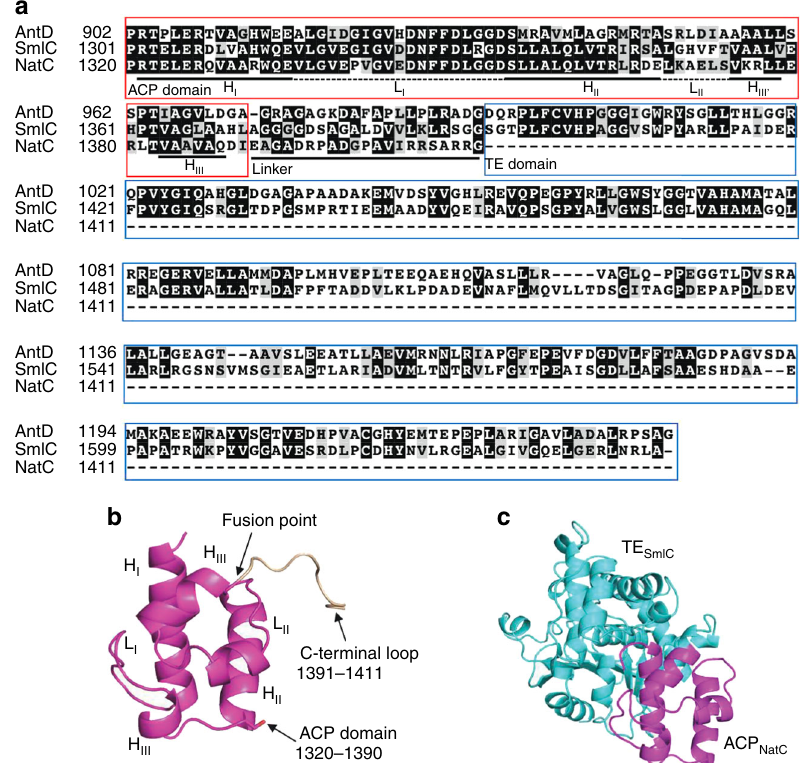
Fig. 2 Bioinformatic analyses of the antimycin PKS modules. a Alignment of the PKS modules, AntD, SmlC, and NatC. We annotated SmlC 1301 – 1371 as an ACP domain (region 1), SmlC 1372 – 1392 as an interdomain linker, SmlC 1393 – 1647 as a TE domain (region 2), and NatC 1391 – 1411 as a docking domain. b A homology model of ACP NatC (1320 – 1411), based on the reported crystal structure of the surfactin synthase ACP subunit (PBD: 2VSQ) as the template. c A homology model of the ACP NatC- TE SmlC domains, the NRPS module from Acinetobacter baumannii (NCBI PBD ID 4ZXH_A, https://www.ncbi.nlm.nih.gov/ protein/4ZXH_A) was used as the